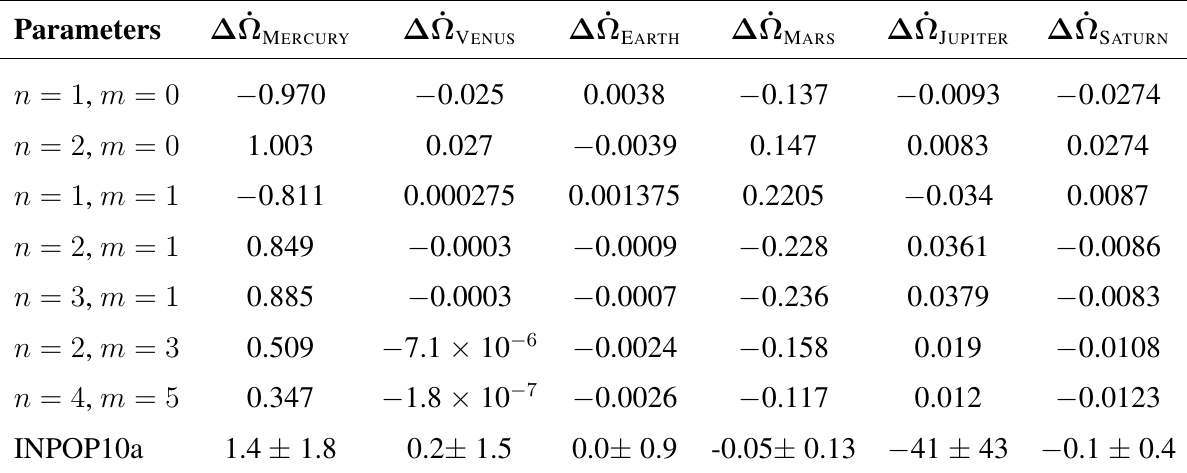
Table 3. The extra advance of the longitude of the ascending node for the planets as induced by the unconventional transversal gravitomagnetic field. The last column list the values and confidence intervals found by Fienga et al . [18] in milliarcseconds per century.